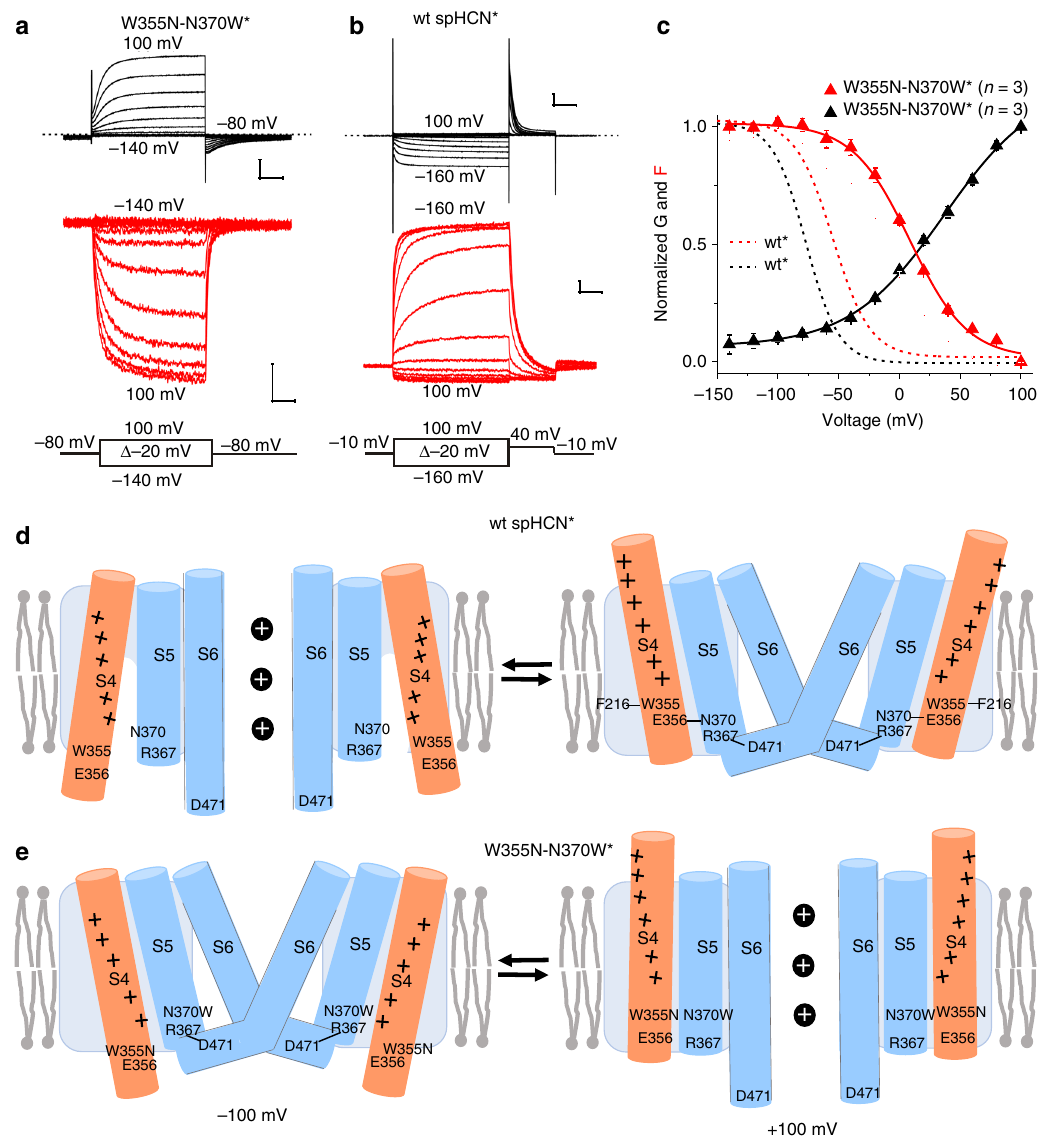
Fig. 4 W355N – N370W switches the polarity of voltage activation. a , b Currents (black) and fl uorescence (red) from W355N – N370W * and wt spHCN * channels using holding voltages of a − 80 mV and b − 10 mV. Scale bars: 0.1 s, 5 µ A, and 1% Δ F/F . c G(V) and F(V) curves of wt * and W355N – N370W * channels. Mean± SEM. d W355-F216, N370-E356, and R367 – D471 interactions hold wt* channels closed 7,21 . Downward S4 movement breaks these interactions and exposes N370 to water- fi lled crevice. e W355N – N370W removes stabilizing interactions in closed state with S4 up and destabilize water- fi lled crevice in open state with S4 down. See Supplementary Figs. 3 – 5 and Supplementary Movies 1 – 2 for more details. Source data are provided as a Source Data fi